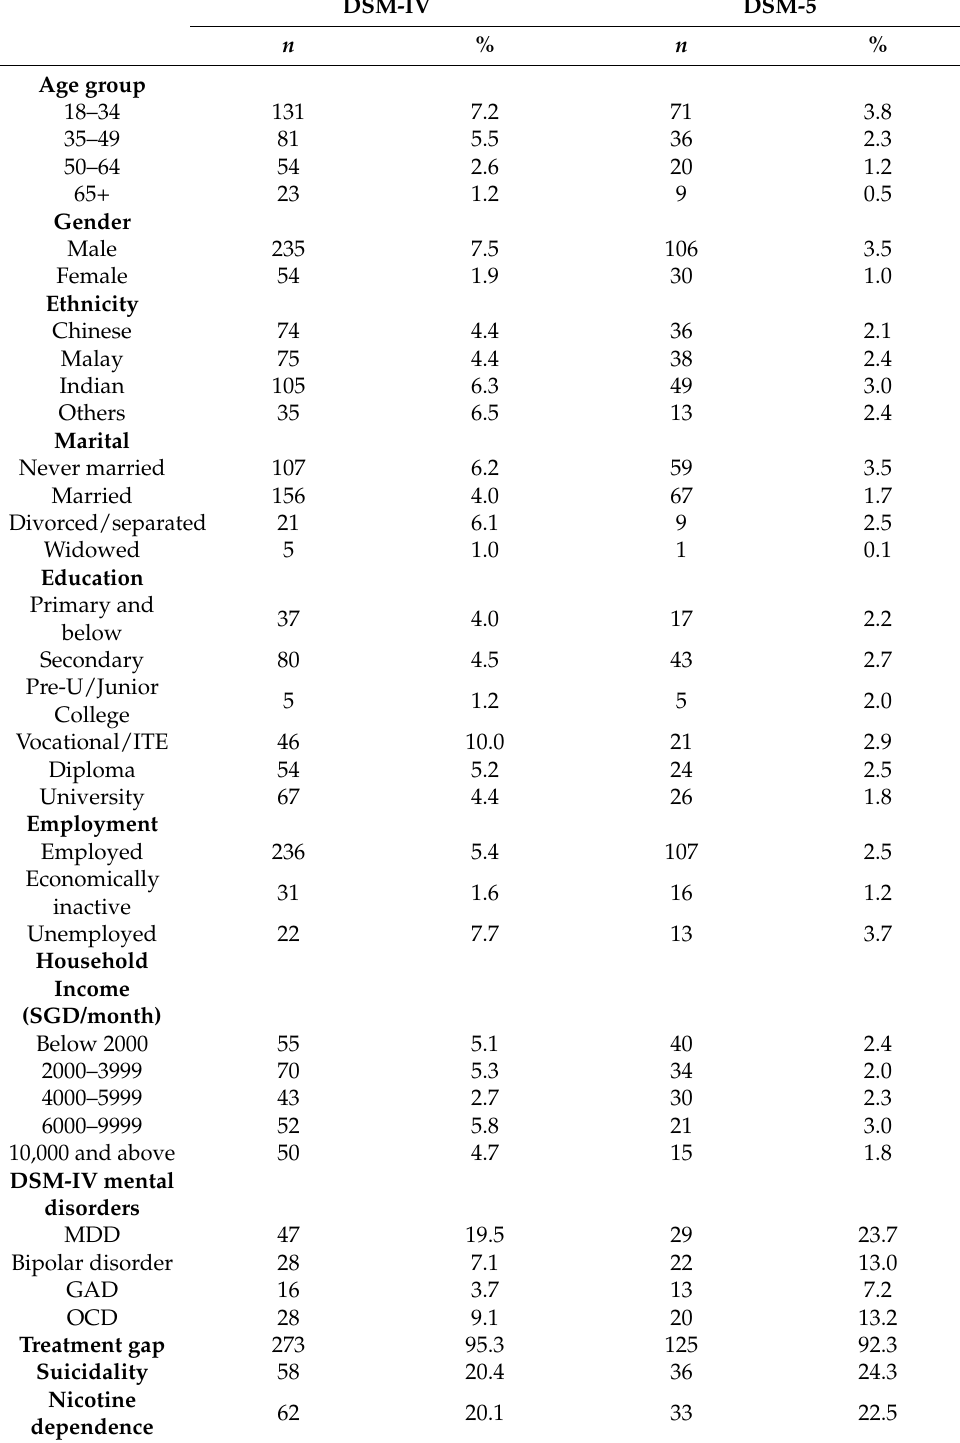
Table 2. The lifetime prevalence of DSM-IV and DSM-5 alcohol use disorder by sociodemographic and clinical